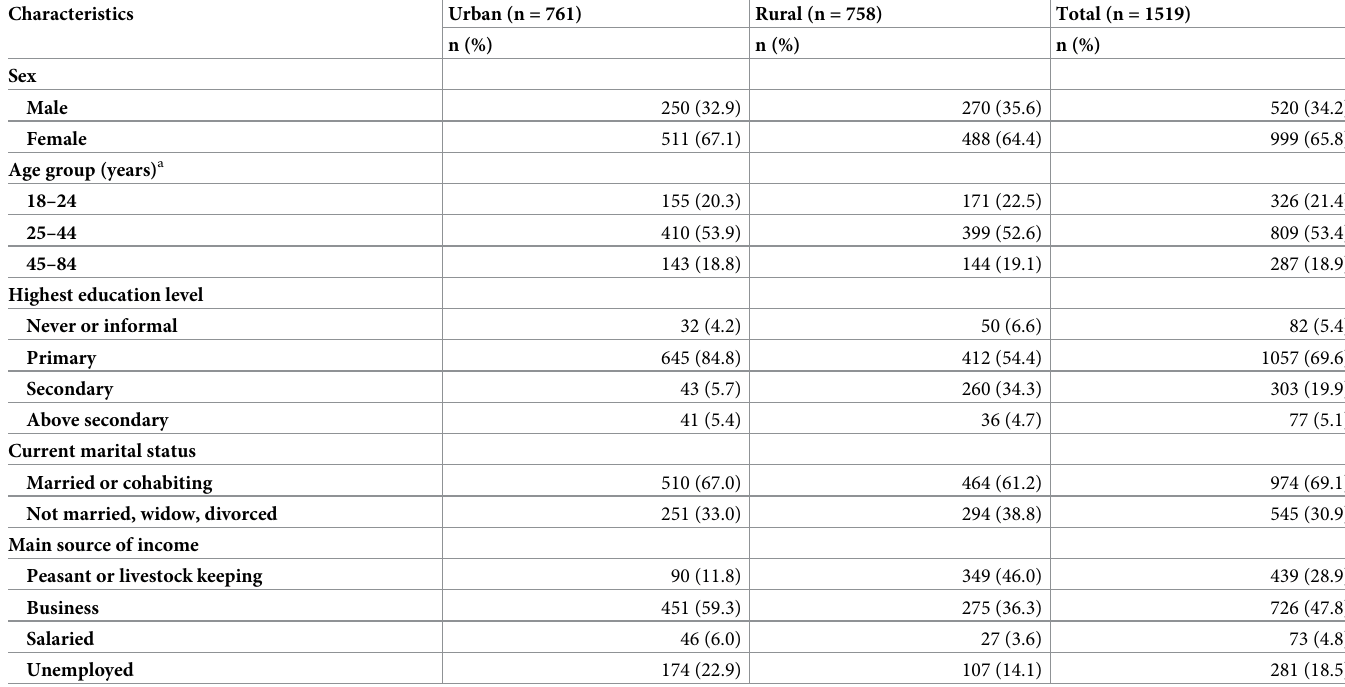
Table 1. Distribution of study participants by background characteristics and place of residence.